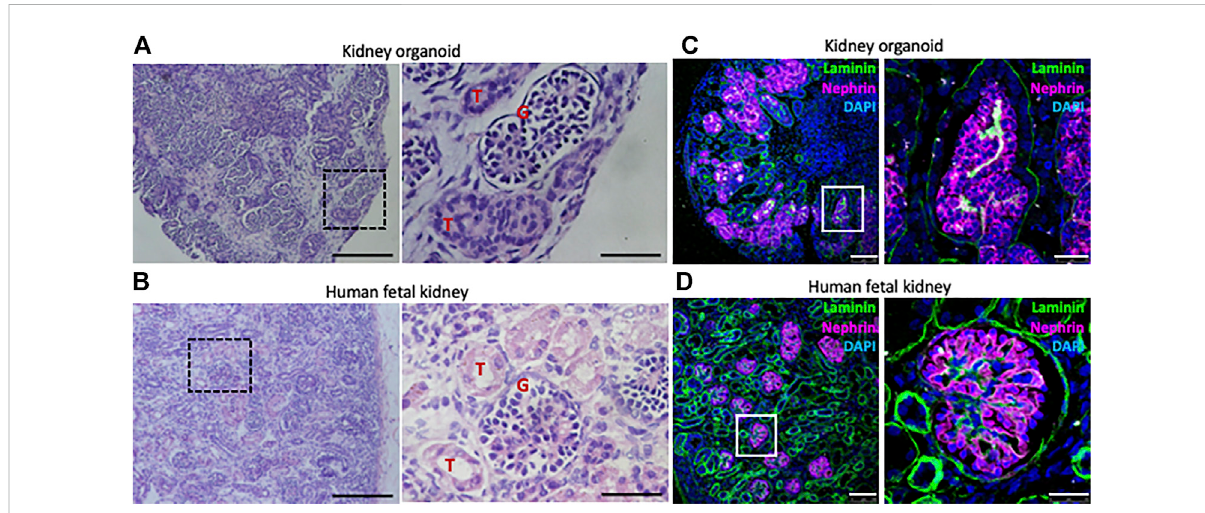
FIGURE 2 hPSC-derived kidney organoids display renal features that partially resemble those in human fetal kidneys. Histological analysis of kidney organoid (A) and 22 weeks of gestation human fetal kidney (B) . Higher magni fi cationsof the boxed areas show details ofglomeruli (G) and tubule (T) structures.Scalebars,200and50 µm(highermagni fi cations).Immunohistochemistryofkidneyorganoid (C) and22 weeksofgestation humanfetal kidney (D) for thedetection ofthebasement membraneproteinLamininand thepodocyte markerNephrin.Cellnuclei are counterstainedwith DAPI. Higher magni fi cations of the boxed areas show details of glomerulus found in kidney organoid compared to human fetal kidney. Interestingly, nephrin + podocyte-like cells in kidney organoids are aligned on the basement membrane (laminin + ) following a similar distribution as in the human fetal kidney. Scale bars, 100 and 25 µm (higher magni fi